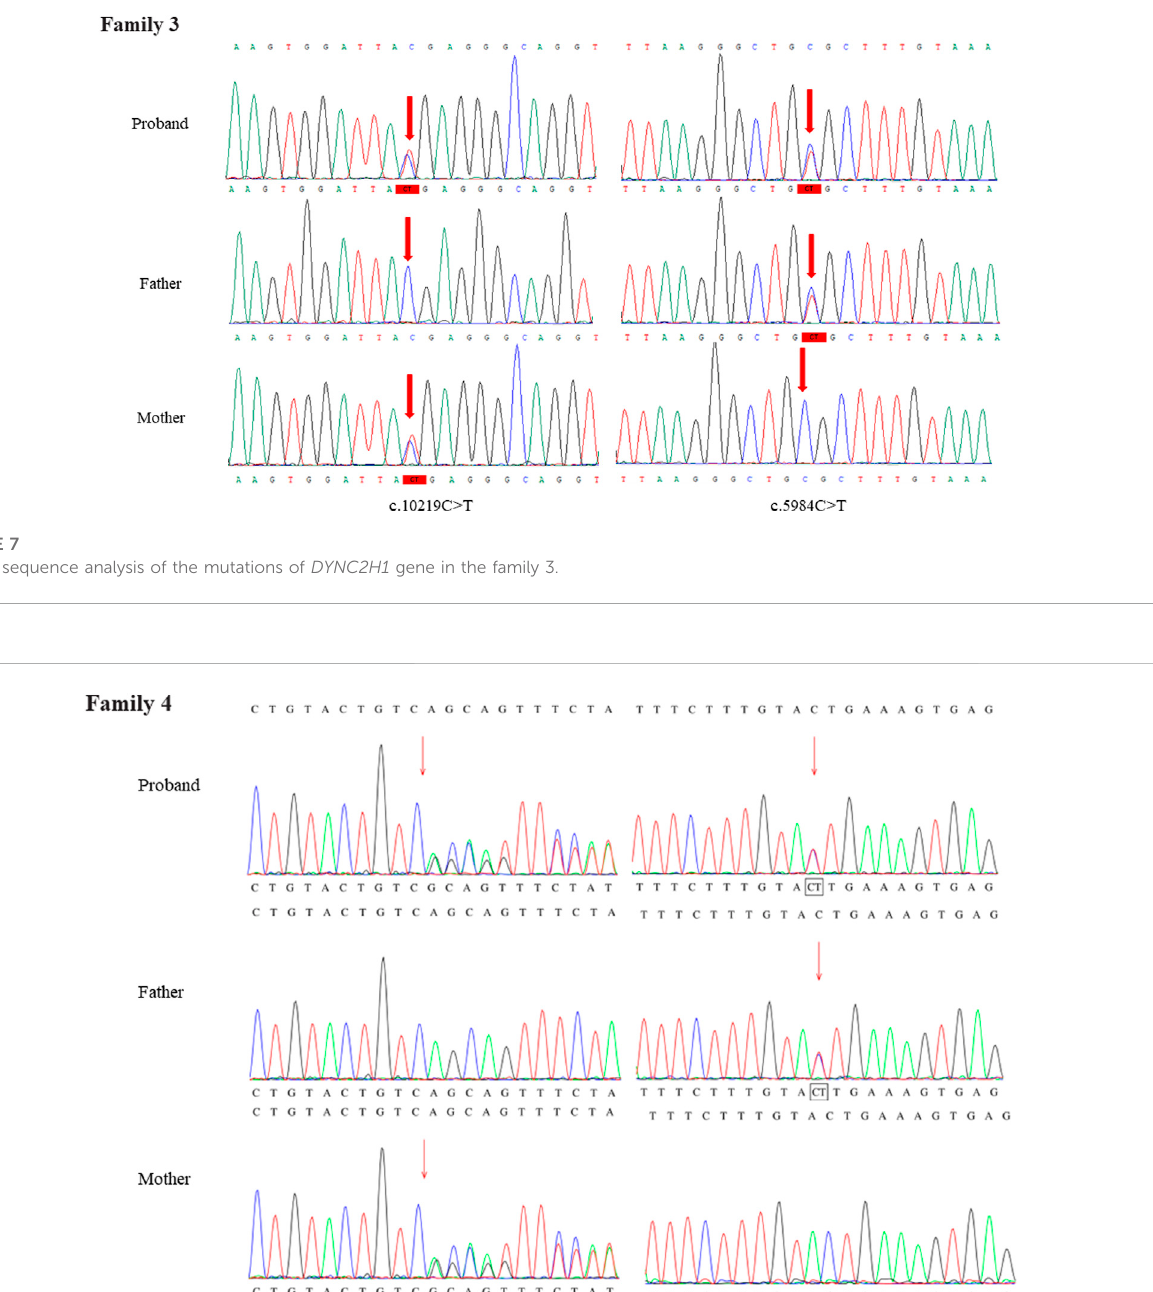
(Figure 10B). Among which, the top one protein with higher degrees was DYNC2H1 (degree = 10). Then, these 11 genes in protein-protein interaction network were utilized to perform the GO enrichment analysis. Top 10 signi fi cantly GO terms were displayed in the Figure 10C. GO terms enrichment analysis showed that ciliary tip, intraciliary transport, intraciliary retrograde transport, cytoplasmic dynein complex, intraciliary transport particle, ciliary plasm, centrosome, ciliary basal body, appendage development, motile cilium were signi fi cantly enriched GO terms.